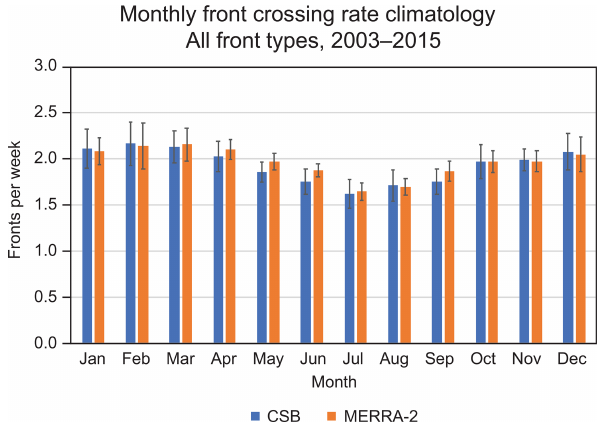
Figure 9. Comparison of the front/no-front CSB and DL-FRONT MERRA-2 monthly front crossing rate climatologies spatially aver- aged across the entire CONUS